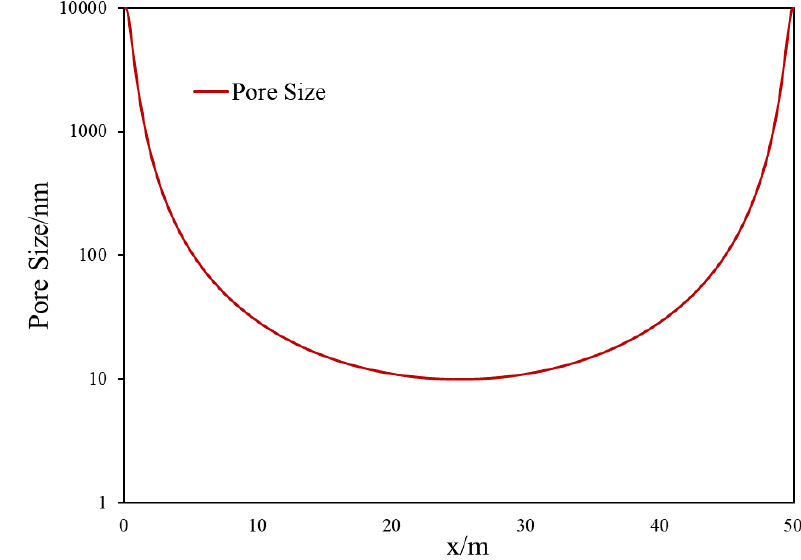
Figure 3. Pore size and capillary pressure distribution for slim tube simulation.